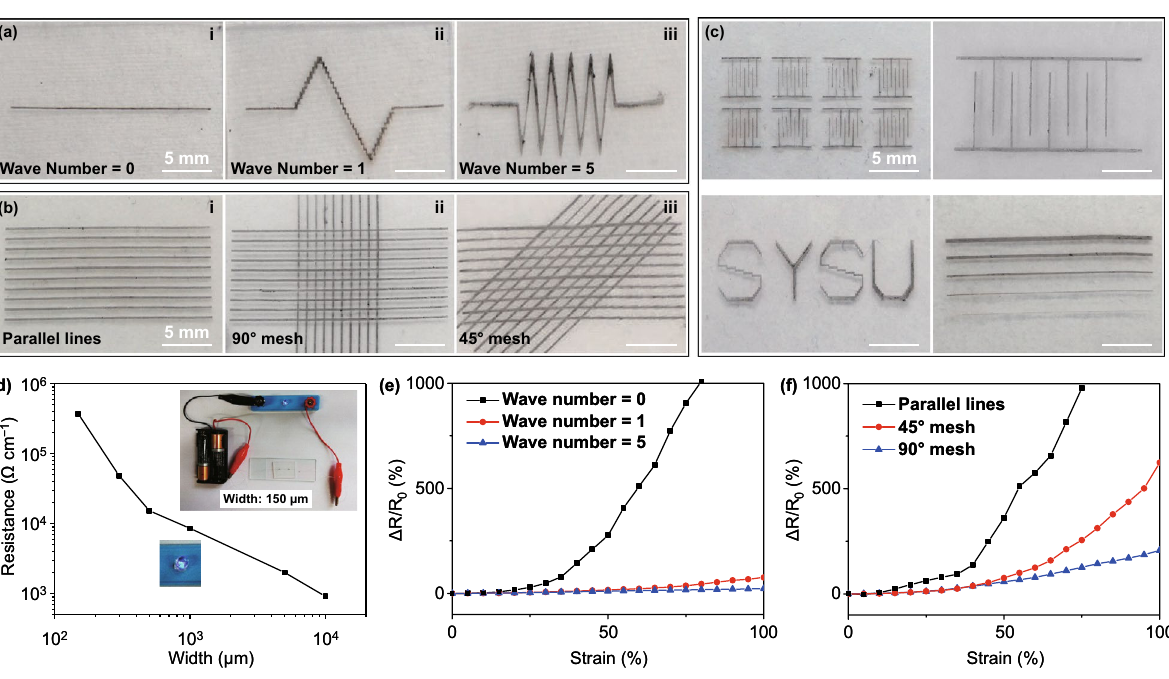
Fig. 4 Transferred CNT films with different patterns and their electromechanical properties. a Optical camera images of wavy CNT strip with different wavenumbers. b Transferred CNT film with different mesh structures. c The different patterns of CNT network including an interdigital electrode, characters and strips with different line width. d The resistance of CNT strips with different line width. e Electromechanical properties of the strain sensor with different wave number pattern. f Electromechanical properties of the strain sensor with different direction mesh